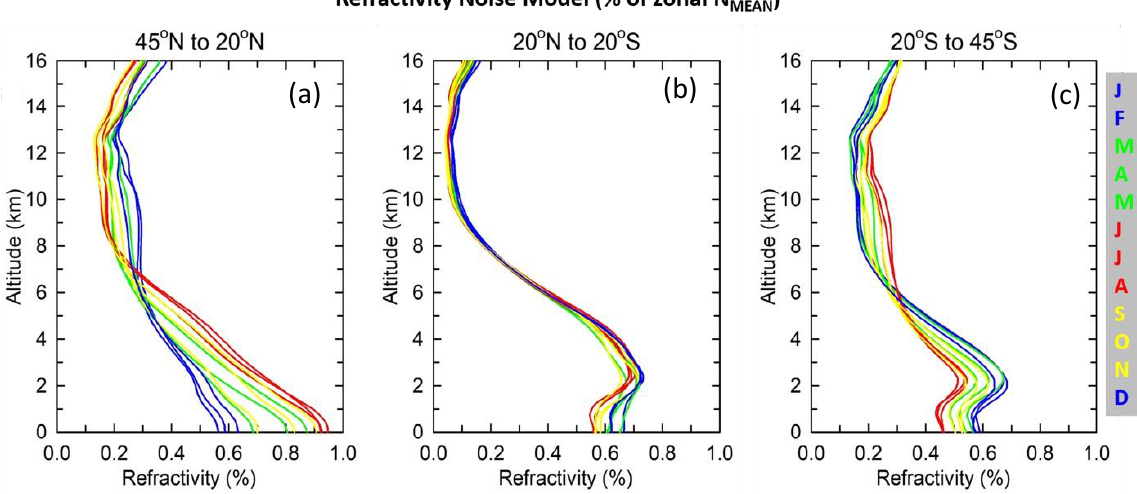
Figure 5. The error covariance model (in %) used in the optimal estimation: ( a ) northern mid-latitudes 60 ◦ N to 20 ◦ N, ( b ) tropics 20 ◦ N to 20 ◦ S, ( c ) southern mid-latitudes 20 ◦ S to 60 ◦ S. Each panel presents 12 months where blue lines (December, January, and February) are for northern winter, green lines are for northern spring (March, April, and May), and red lines for northern summer (June, July, and August), and yellow lines (September, October, and November) are for northern autumn.